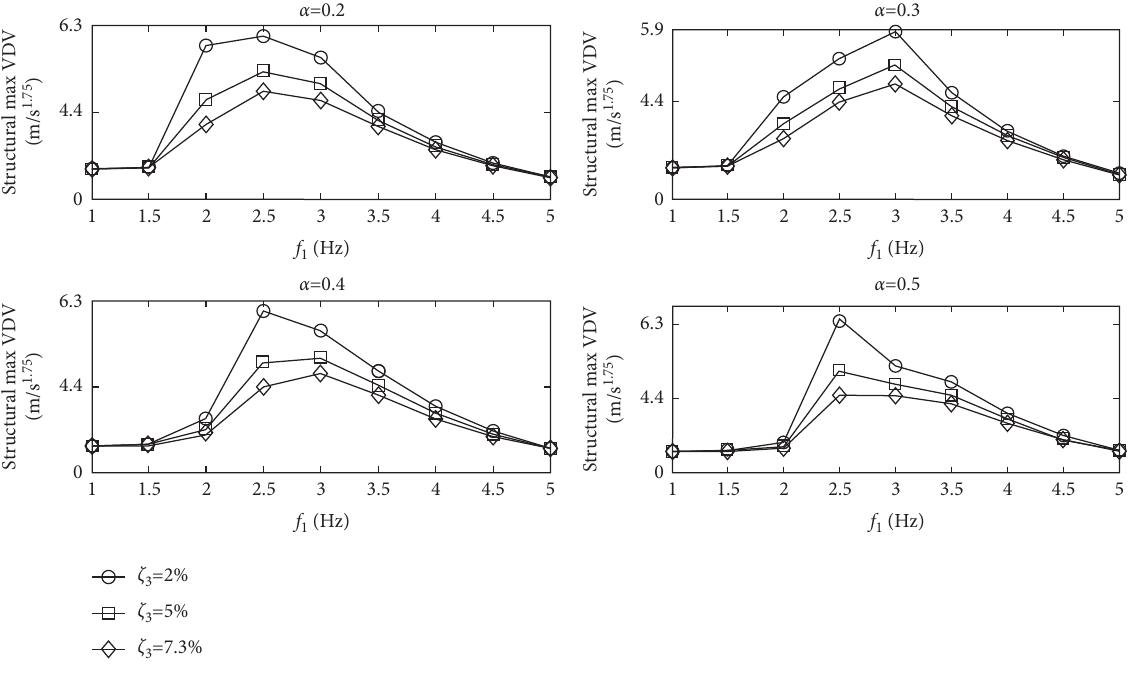
Figure 26: The max VDVs corresponding to structural dynamic